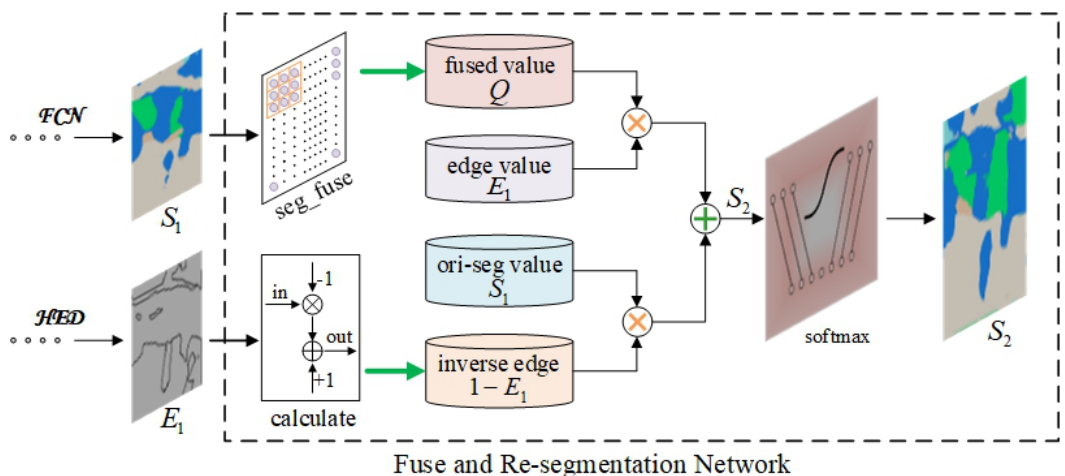
Figure 6. Architecture of Correct-Edge-FCN network. This network draws on the Domain Transform algorithm in one-dimensional signals and introduces edge information as a correction coefficient into the semantic segmentation